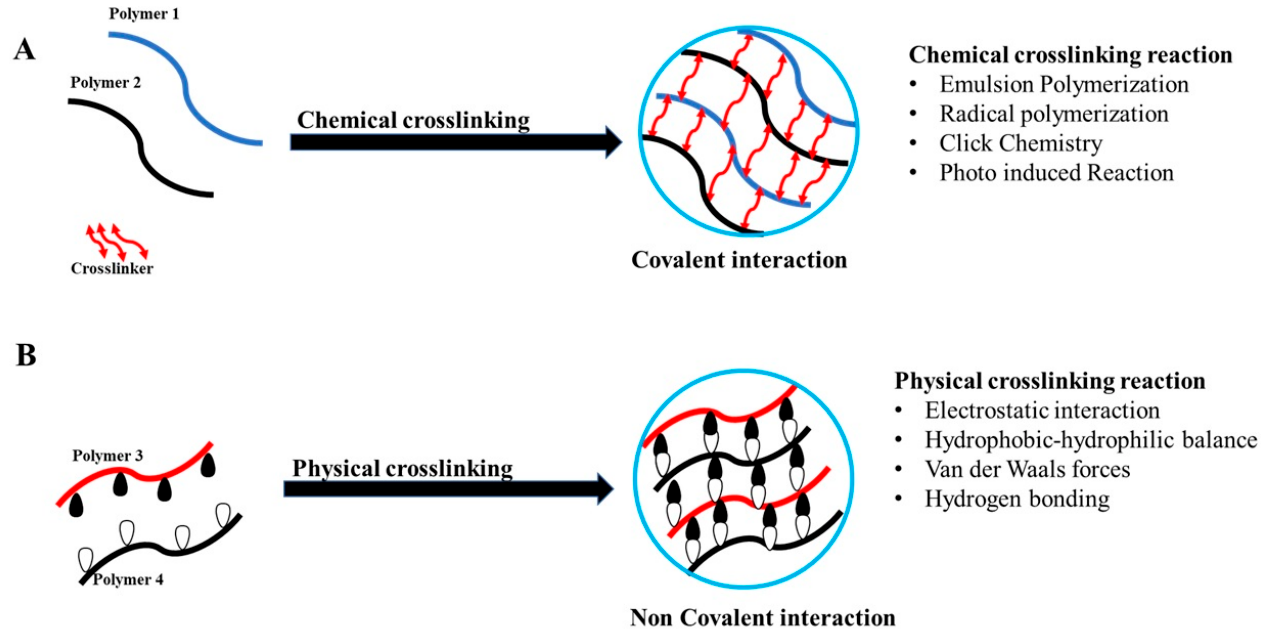
Figure 1. The design of nanogels (NG) using chemical and physical crosslinking processes is depicted. ( A ) Covalent bond formation (crosslinking points, in red) using different chemical reactions generated by the interaction of reactive moieties between polymers 1 and 2. ( B ) The self-assembly of a nano-scaffold is enabled by the physical interactions between polymers 3 and 4 [2].